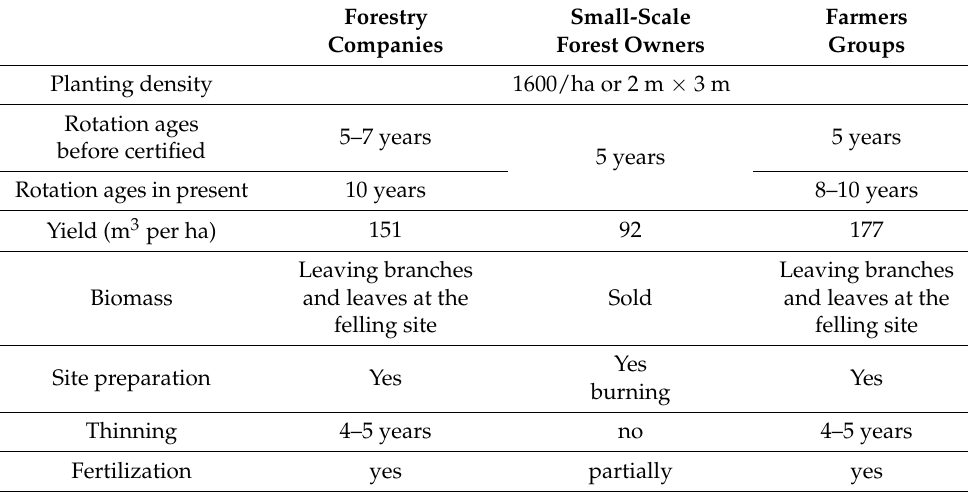
Table 3. Comparison of operation by type of timber supplier.